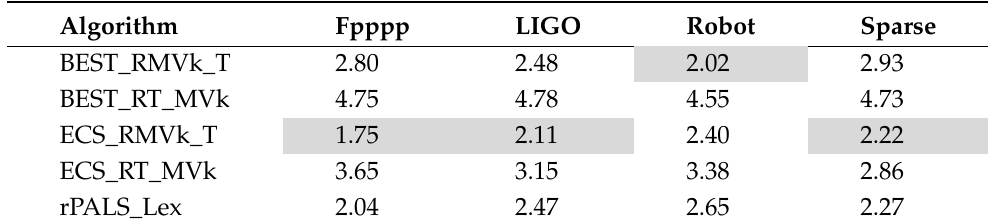
Table 13. Makespan Friedman rankings (b-level).